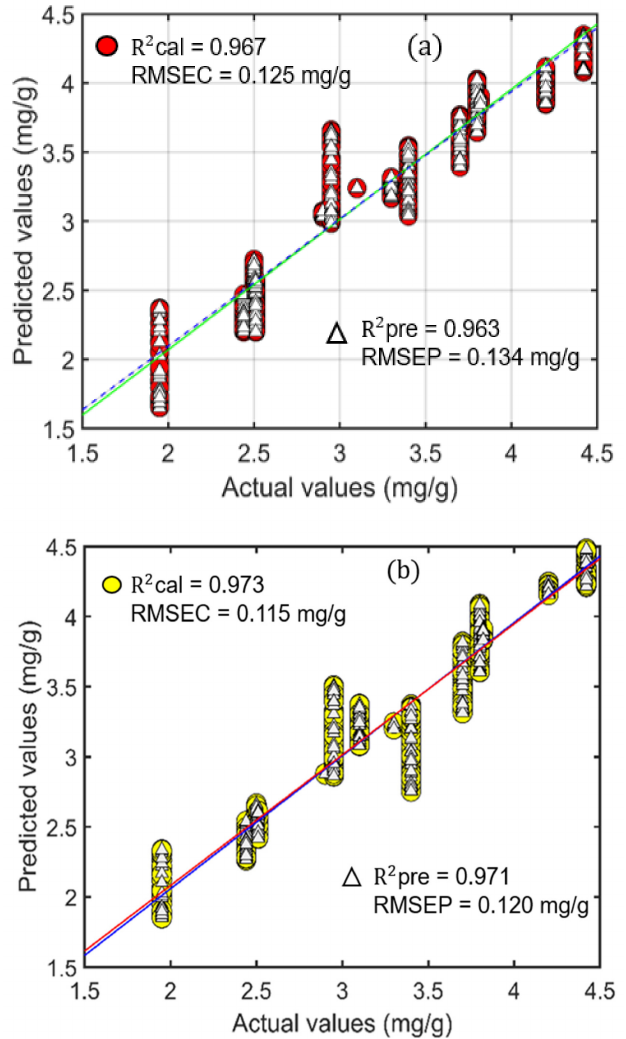
Figure 6. PCR ( a ) and hybrid linear analysis (HLA/GO) ( b ) graphs of actual versus predicted concentration for the phenolic compounds in moringa powder for the calibration and prediction datasets ( a ). RMSEC and RMSEP represent the root mean square error of calibration and